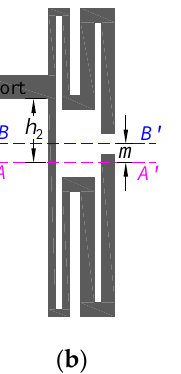
Figure 8. The resonator with port. ( a ) Type I; ( b ) type II.